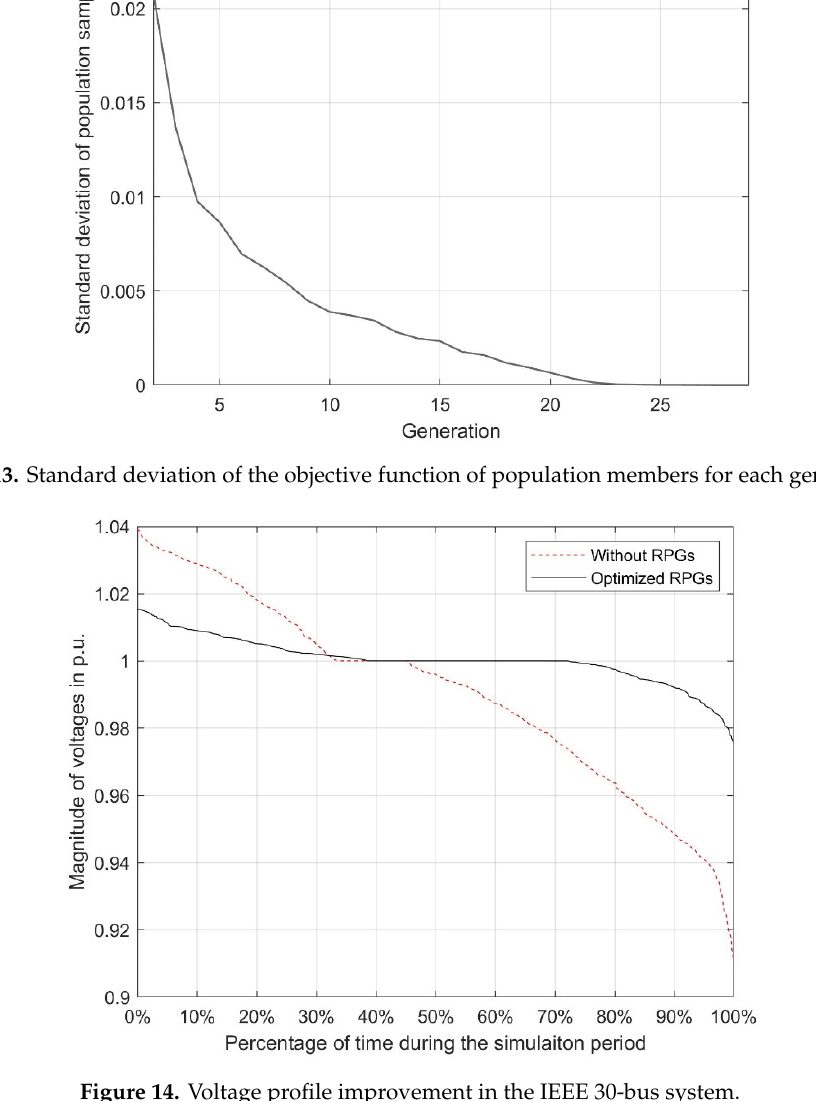
Figure 14. Voltage profile improvement in the IEEE 30-bus system.